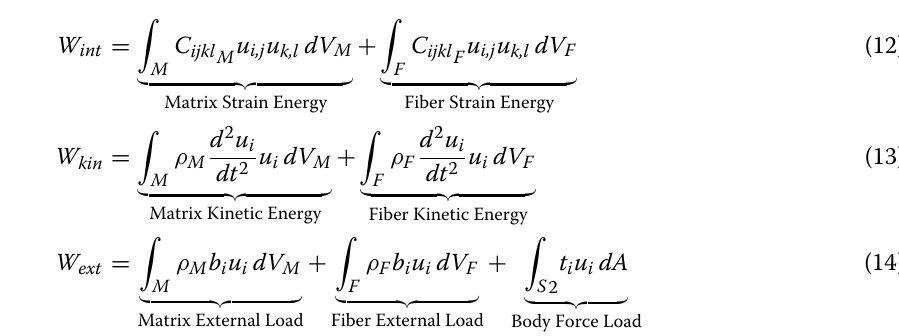
Fig. 5 a shows how the volume redundancy is created in the embedded element method. b shows how to correctly model the system